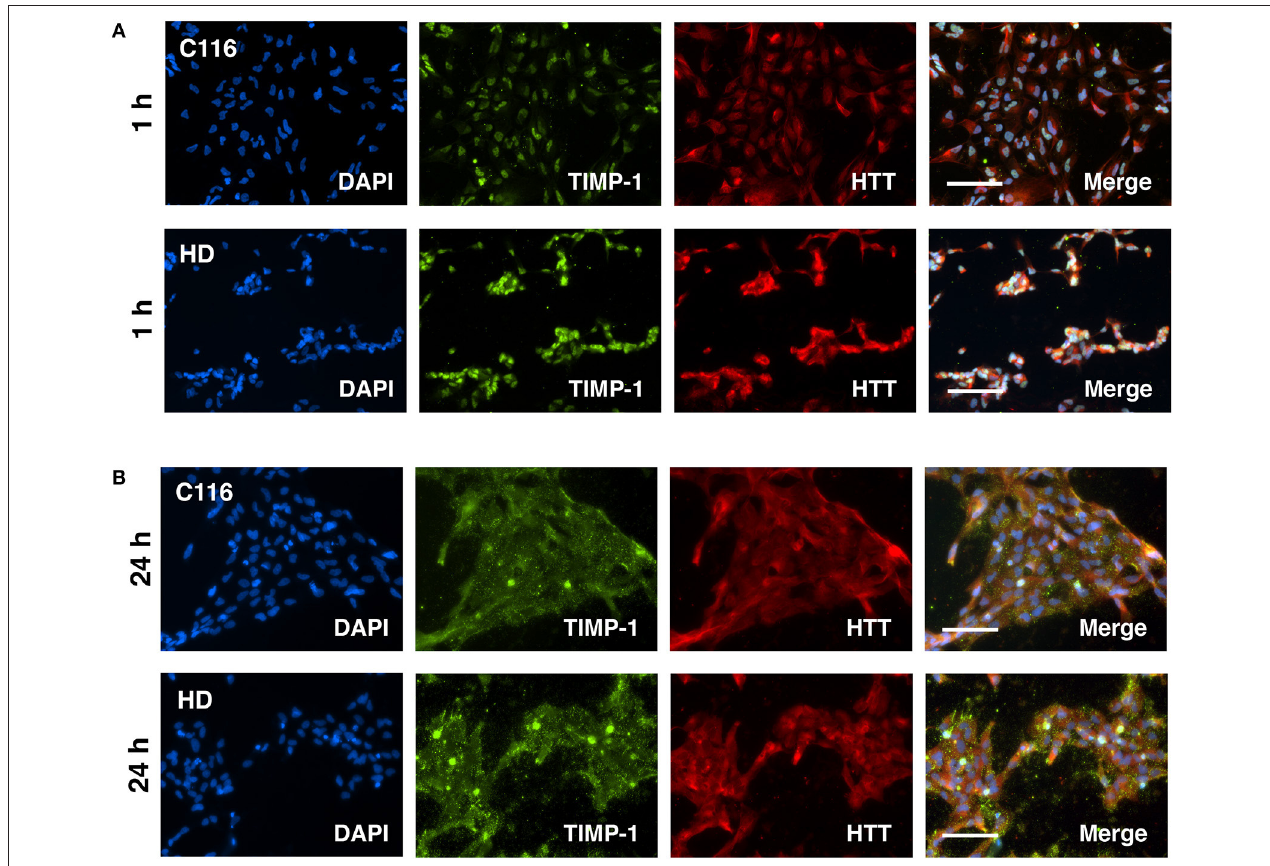
FIGURE 7 | Altered localization of TIMP-1 in response to TGF- β treatment as a function of time. C116- and HD-NSCs were treated with 20ng/mL TGF- β . (A) Immunofluorescence analysis shows robust induction of TIMP-1 levels in HD-NSCs. Strong nuclear expression of TIMP-1 is observed in both C116- and HD-NSCs. However, the expression becomes predominantly cytoplasmic after 24h of TGF- β treatment (B) across both genotypes. Scale Bars: 100 µ